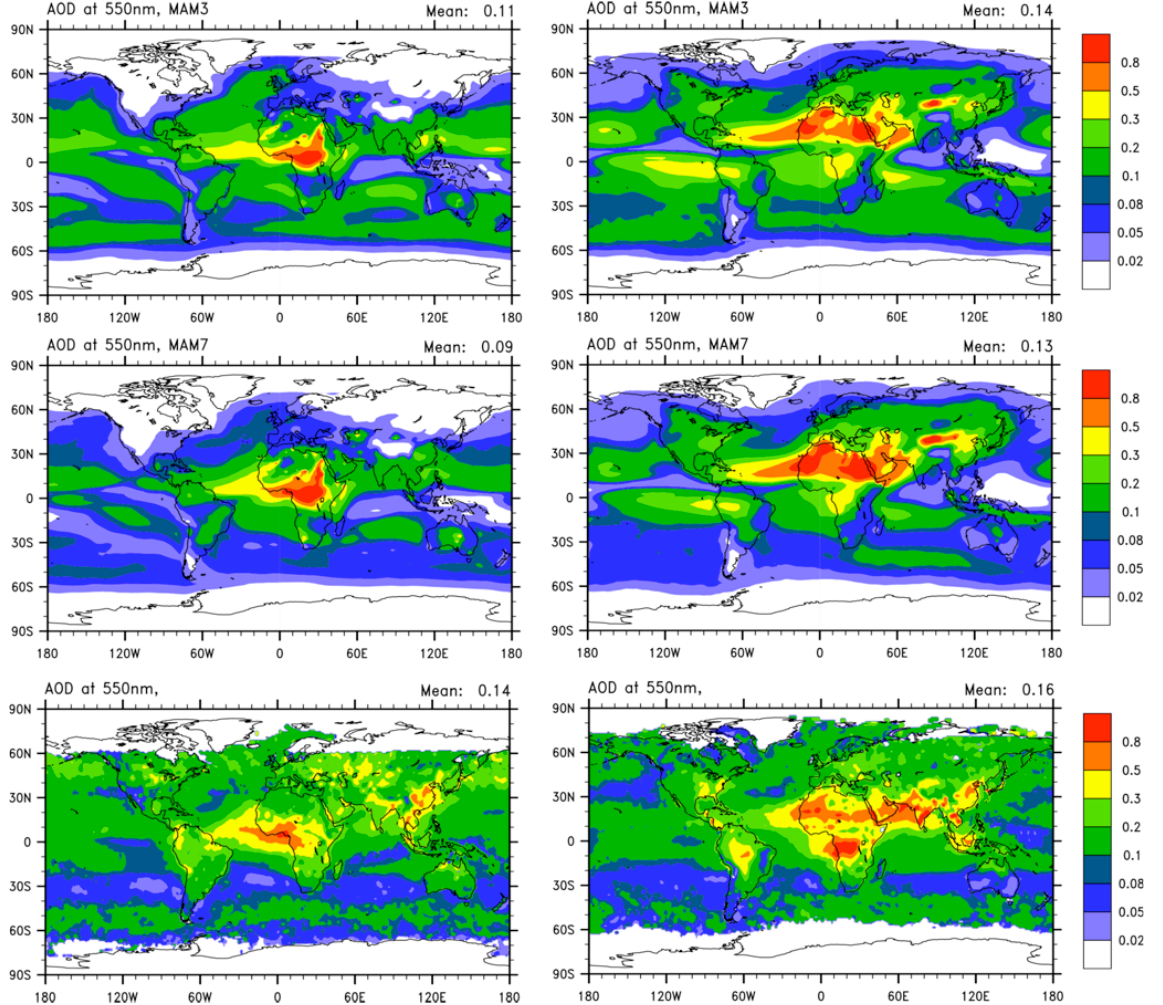
Fig. 25. Comparison of simulated AOD at 550nm from MAM3 (upper) and MAM7 (middle) in January (left) and July (right) with that from a satellite AOD retrieval composite (lower), derived by Kinne et al.